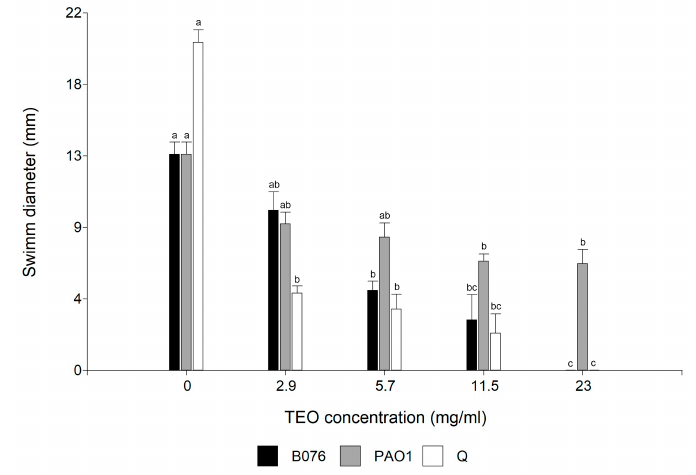
Figure 7. The effect of different concentrations of TEO on swimming motility (0.3% agar) in P. syringae Q, P. savastanoi pv. glycinea BO76 and P. aeruginosa PAO1, observed after 48 h of incubation. The results are expressed as the mean ± standard error (SEM) of the swimming diameter in millimetres (mm). Means with different letters indicate statistically significant differences ( p < 0.05). Lowercase letters compare the control (0 mg/mL) and the strains treated with different concentrations of TEO. Table 5. Effect of TEO (mg/mL) on the swarming of P. syringae strains and P. aeruginosa PAO1. Strains